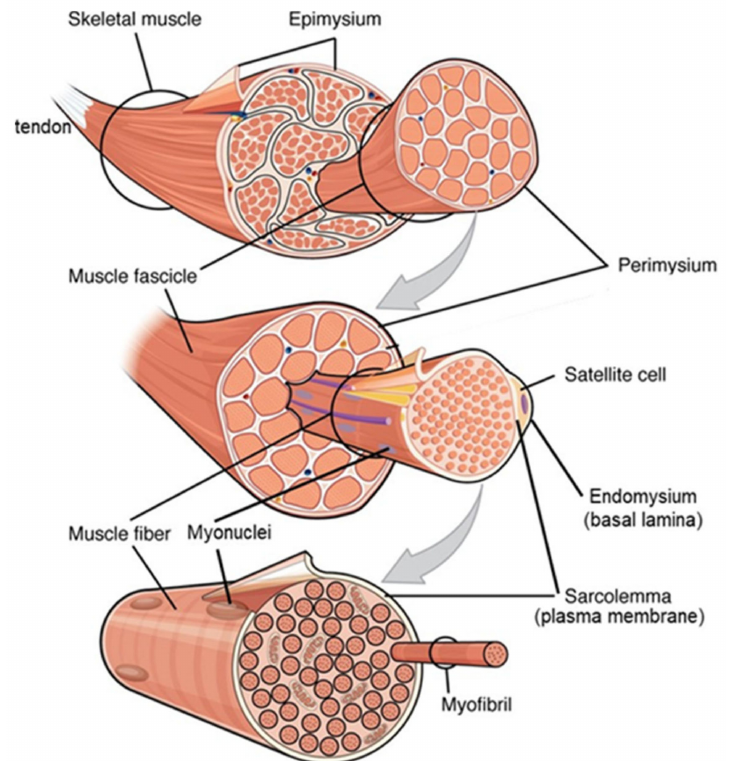
Figure 3. The three connective tissue layers or “bags” which define the volume of an individual skeletal muscle. The entire muscle, ( top ) is encased by the epimysium. Bundles of muscle fibres, (fascicles, middle ), are encased by the perimysium. Each muscle cell, ( middle and bottom ), the multi- nucleate myofibre containing the myofibrillar contractile apparatus, is bounded by the sarcolemma or plasma membrane which is encased by the endomysium or basal lamina. Muscle stem cells (satellite cells) reside outside the myofibre between the plasma membrane and the basal lamina. Copied and adapted under the Creative Commons Attribution 4.0 International license from